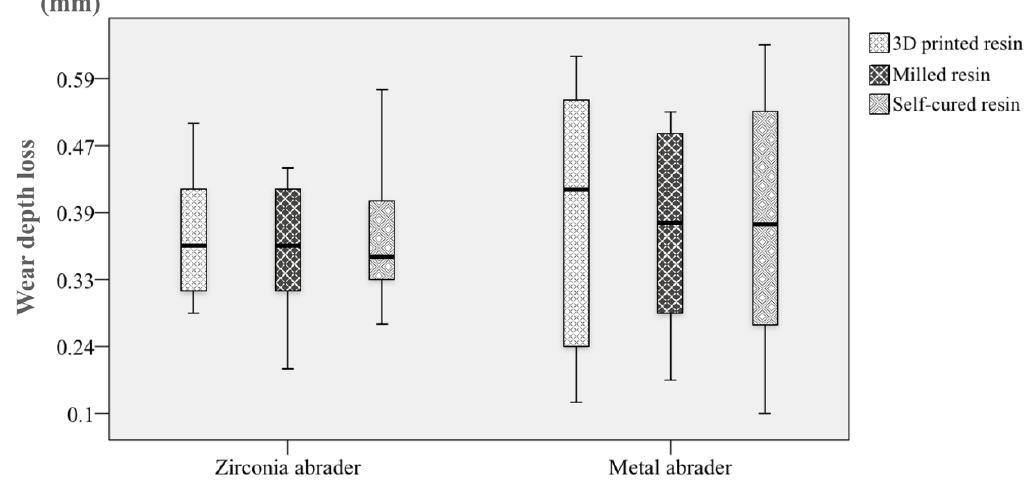
Figure 4. The maximal wear depth loss of the materials against the zirconia and the metal abraders. The length of the box represents the IQRs and the horizontal black line in the box stands for the median. The vertical lines extend to the maximum and minimum values.